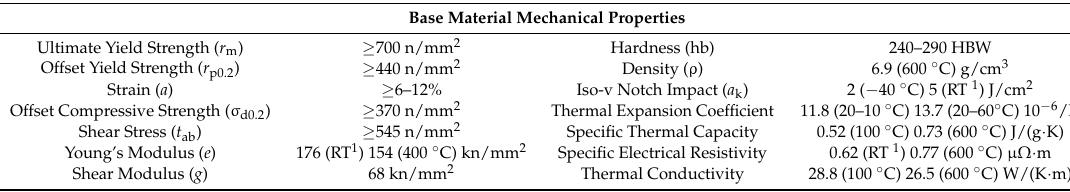
Table 1. Base material main properties